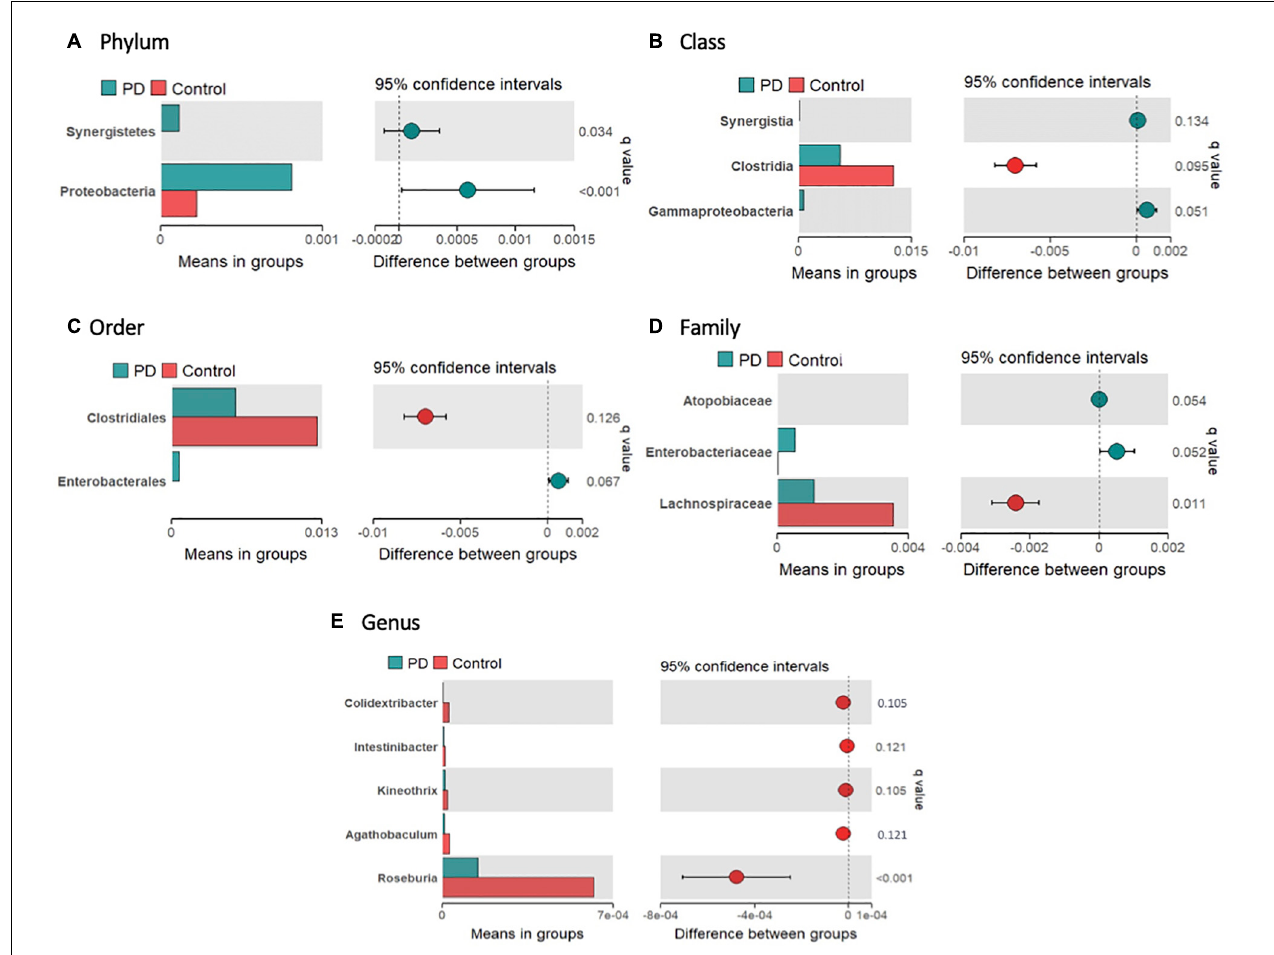
FIGURE 2 | Significantly different taxa in the gut microbiome of controls and PwP following 16S rRNA sequencing. Relative abundance of significantly different bacteria at phylum (A) , class (B) , order (C) , family (D) , and genus (E) levels between controls (red) and PwP (blue). Only bacteria with significant differences are presented. The bars on the left side of each figure show mean relative abundance between PwP and controls. The figures to the right represent the difference between means of PwP and control participants, with error bars representing the 95% confidence interval. Q -values are presented above each individual taxon and were generated using Wilcoxon rank-sum test followed by FDR adjustment with Storey’s q -value. q < 0.15 was considered statistically significant. Figures were created using R v.